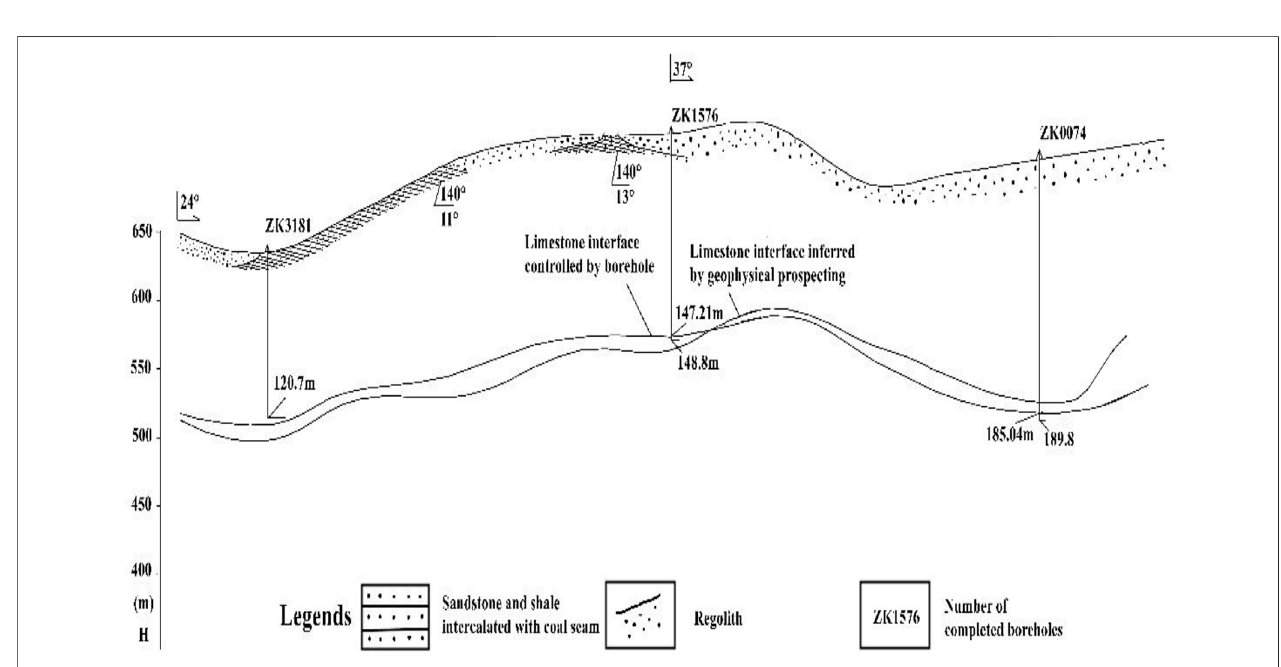
FIGURE 8 | Geological interpretations in accordance with the drilling results. ZK denotes the drilling core.